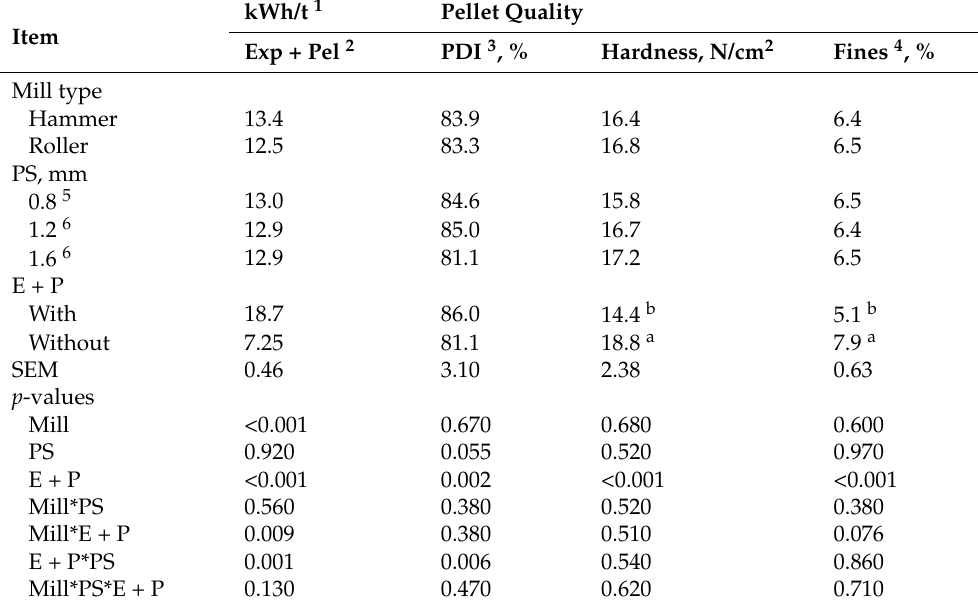
Table 3. Power applied to broiler diets ground using two mill types at three particle sizes (PS), submitted to conditioning with or without expander (E + P) prior to pelleting, and the quality of the resulting